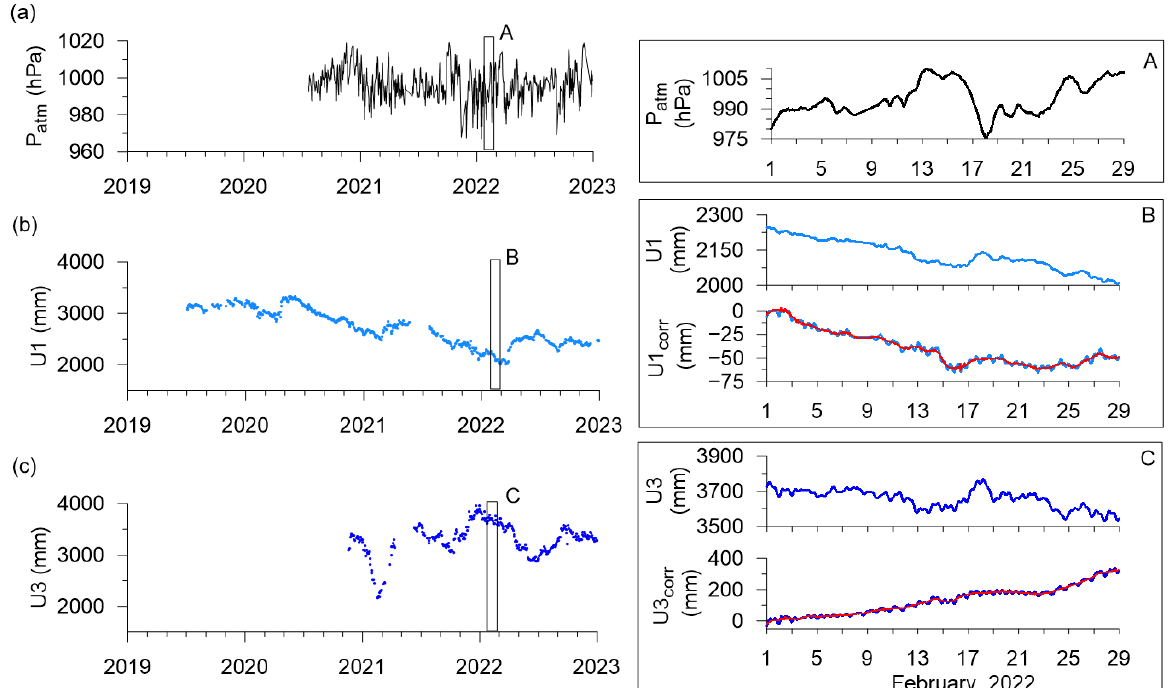
Figure 2. Geological cross section of well #1 in point I (a) and well #3 in point II (b).